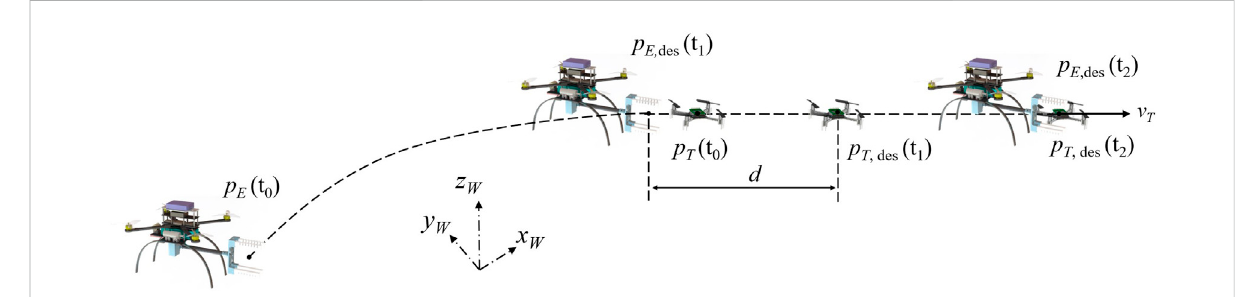
FIGURE 5 Piecewise-polynomial-based planning for a sample catching